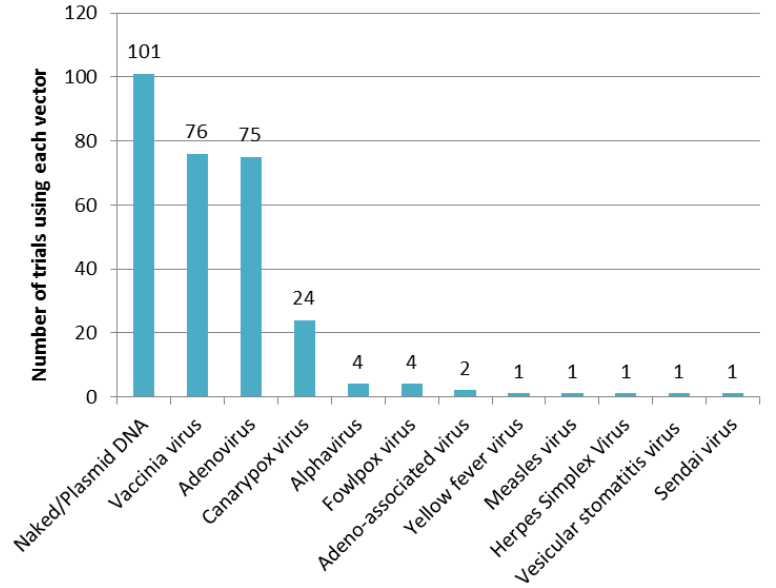
Figure 3. Number of clinical trials using each